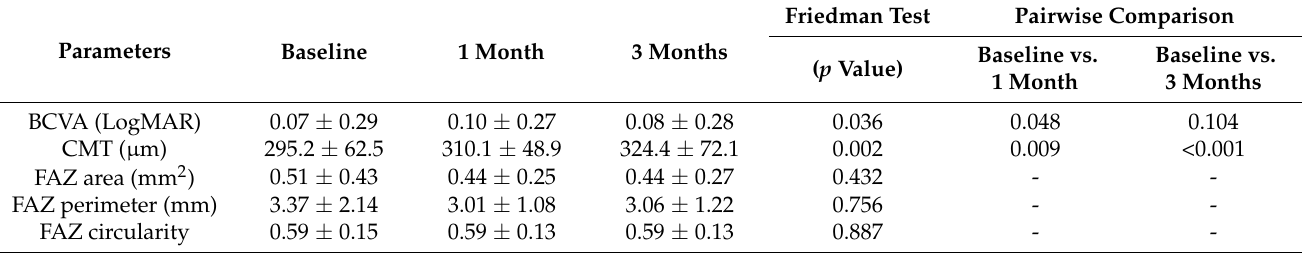
Table 2. Summary of results for all study patients and comparison of the baseline and post-panretinal photocoagulation measurements.